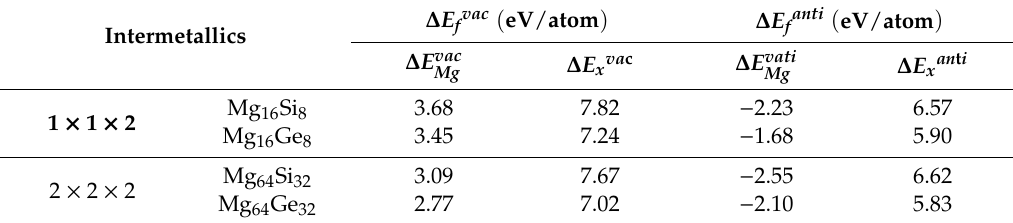
Table 4. Computed ∆ E f vac and ∆ E f anti of Mg 16 X 8 and Mg 64 X 32 (X = Si, Ge) with vacancy and anti-site point